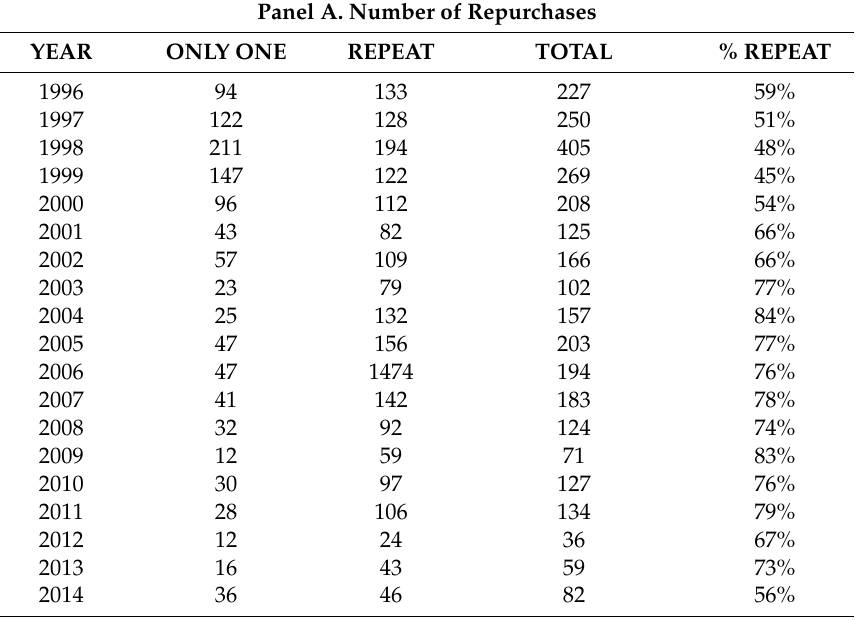
Table 1. Sample distribution and market adjusted